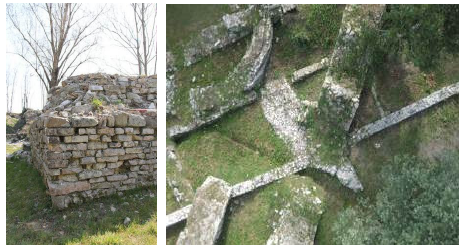
Figure 3. Example of images acquired for terrestrial photogrammetric surveying and using the UAV